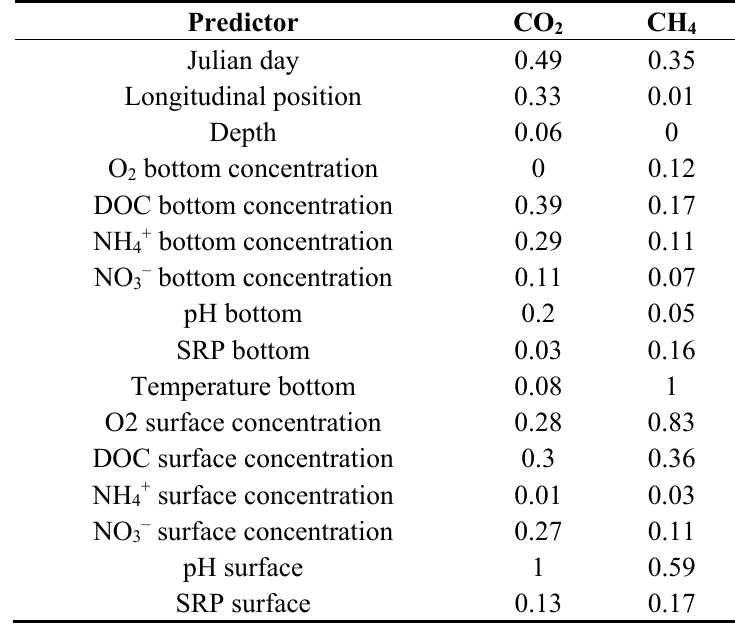
Table 1. Importance of 16 environmental predictor variables in explaining variation in surface diffusion of CO 2 and CH 4 based on thin boundary layer (TBL) estimation at six lentic main lake sites (M1–M6), four lentic cove sites (C1–C4), and three upstream lotic sites (U1–U3). Variable importance was measured as the decrease in node impurity of each Random Forests model with values standardized from 0 to